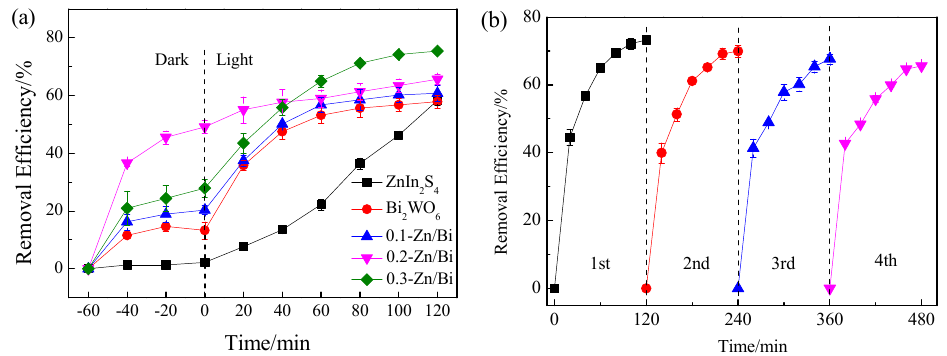
Figure 5. Removal of fluvastatin by as-prepared photocatalyst: ( a ) photocatalytic degradation of fluvastatin; ( b ) the stability of 0.3-Zn/Bi composite photocatalyst for the removal of fluvastatin.